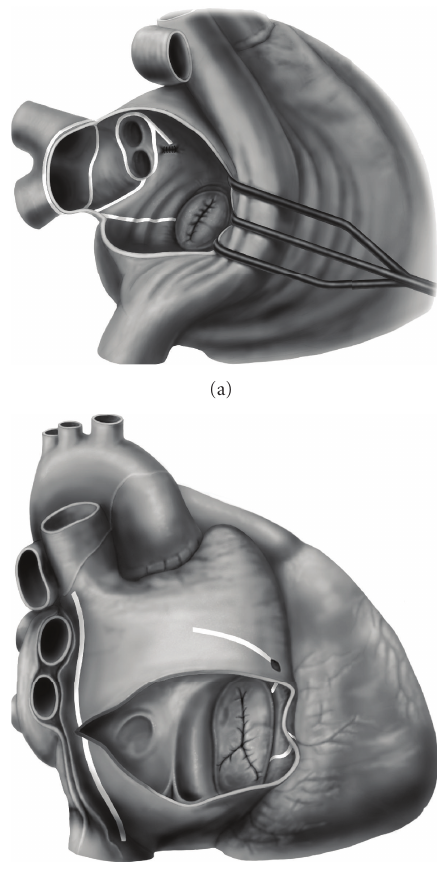
Figure 1: (a) Left atrial Maze III lesion set. (b) Right atrial Maze III lesion